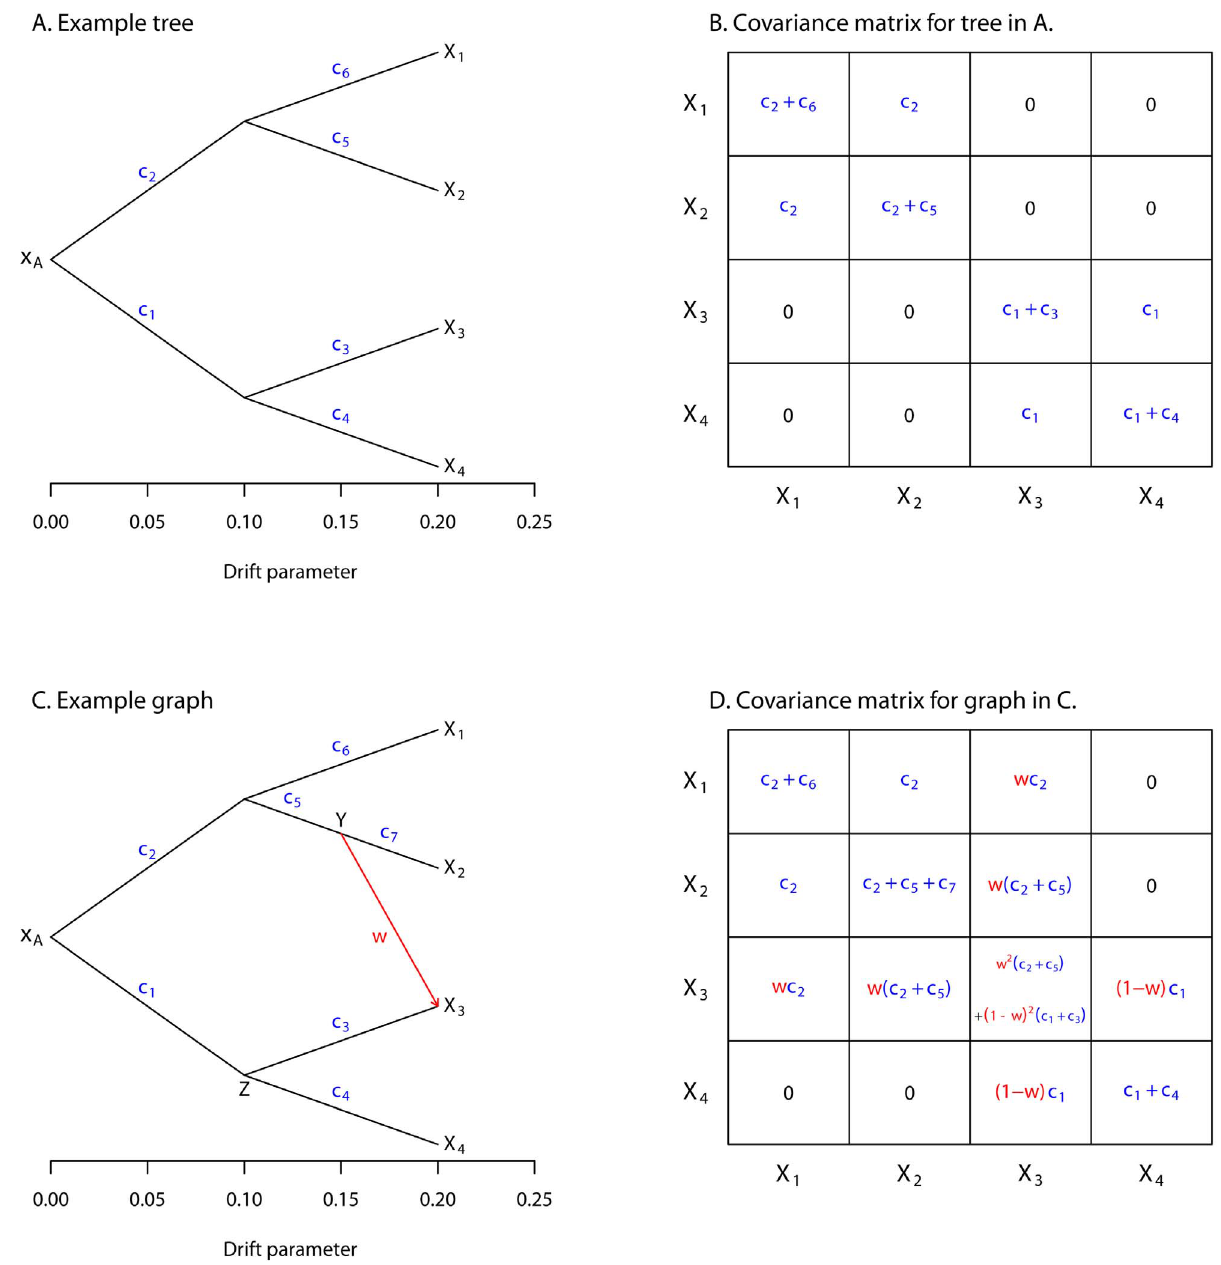
Figure 1. Simple examples. A. An example tree. B. The covariance matrix implied by the tree structure in A. Note that the covariance here is with respect to the allele frequency at the root, and that each entry has been divided by x A ½ 1 { x A (cid:2) to simplify the presentation. C. An example graph. The migration edge is colored red. Parental populations for population 3 are labeled Y and Z ; see the main text for details. D. The covariance matrix implied by the graph in C; again, each entry has been divided by x A ½ 1 { x A (cid:2) . The migration terms are in red, and the non-migration terms are in